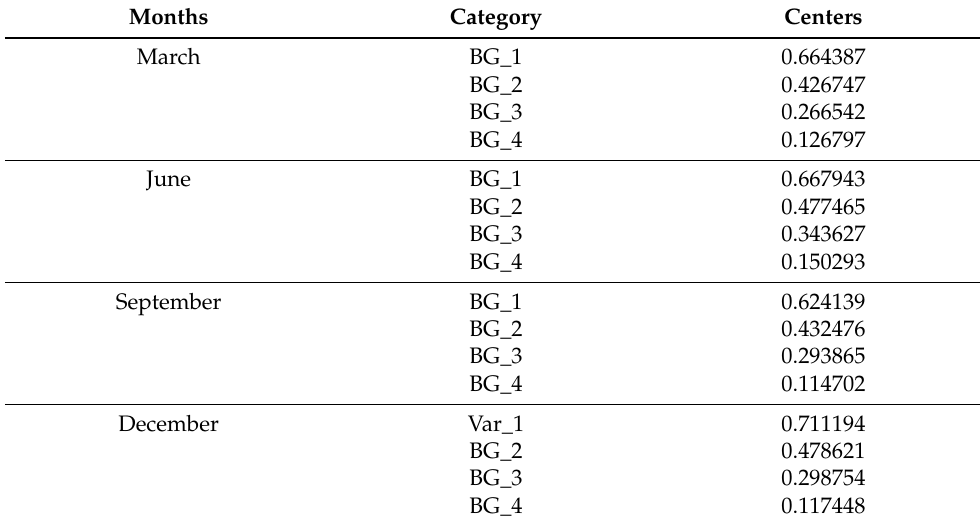
Table 3. Multi-layer nested process of coupled